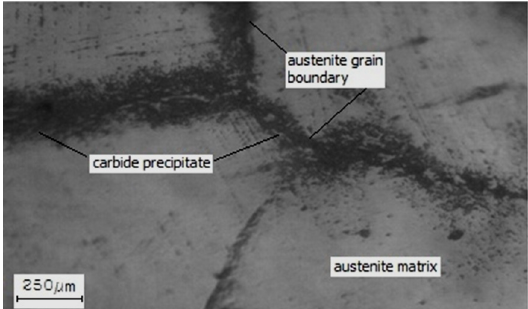
Figure 9. Optical micrograph of sample of failed crusher jaw (F